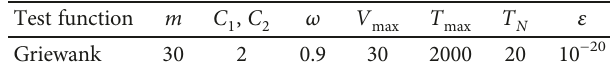
Table 1: The setting of the parameters of the DPSO algorithm and test function.